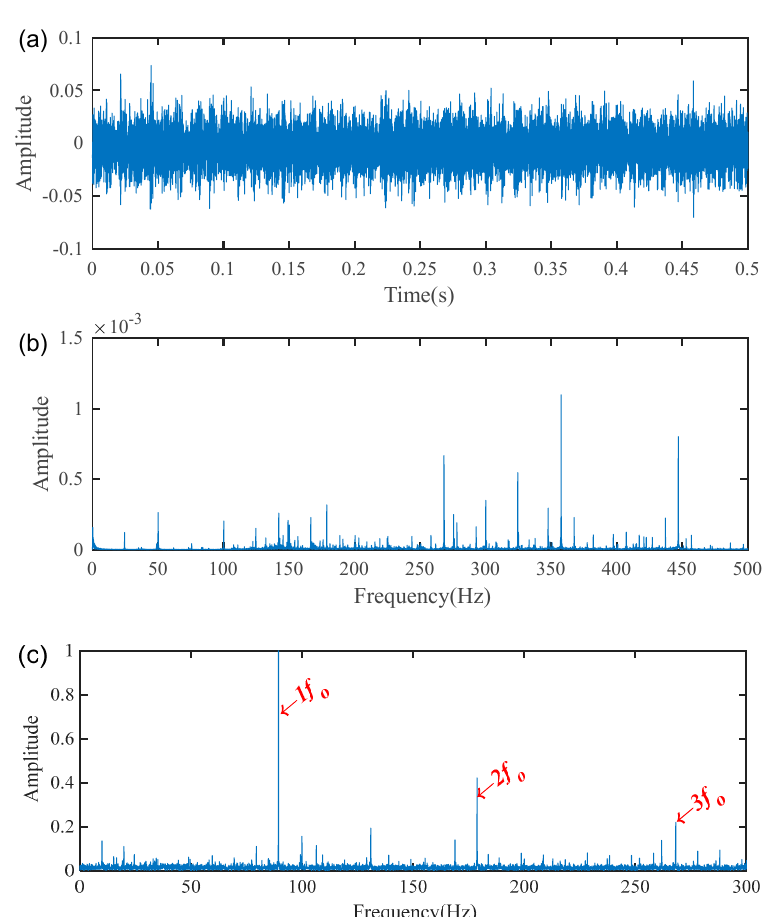
Figure 10. Vibration signal of the bearing with outer race fault: ( a ) waveform; ( b ) spectrum; ( c ) envelope spectrum.